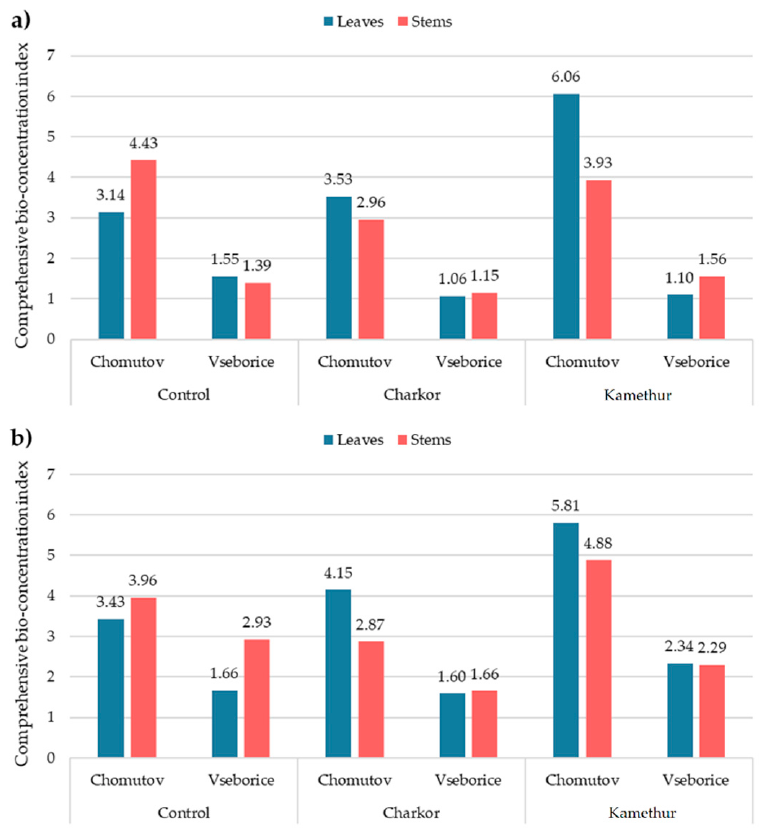
Figure 6. Comprehensive bio-concentration index for: ( a ) elements essential for the plant’s development, and ( b ) elements potentially toxic for the plant’s development.